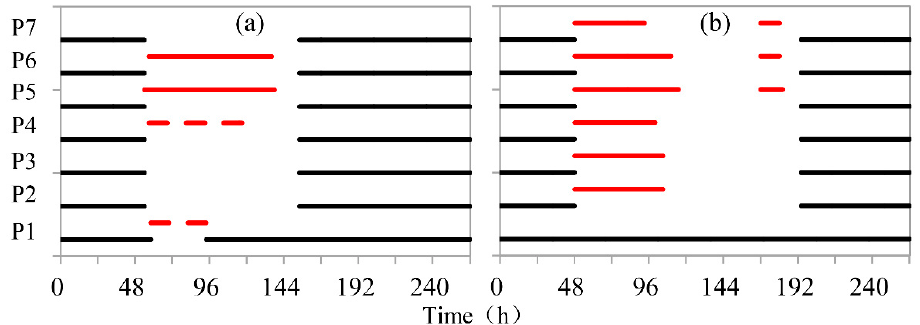
Figure 7. Working flowchart of pumping stations in Rainfall Event 2. ( a ) Original operation and ( b ) optimized operation. Black represents gates and red represents pumps. Serial number of pump Sta-